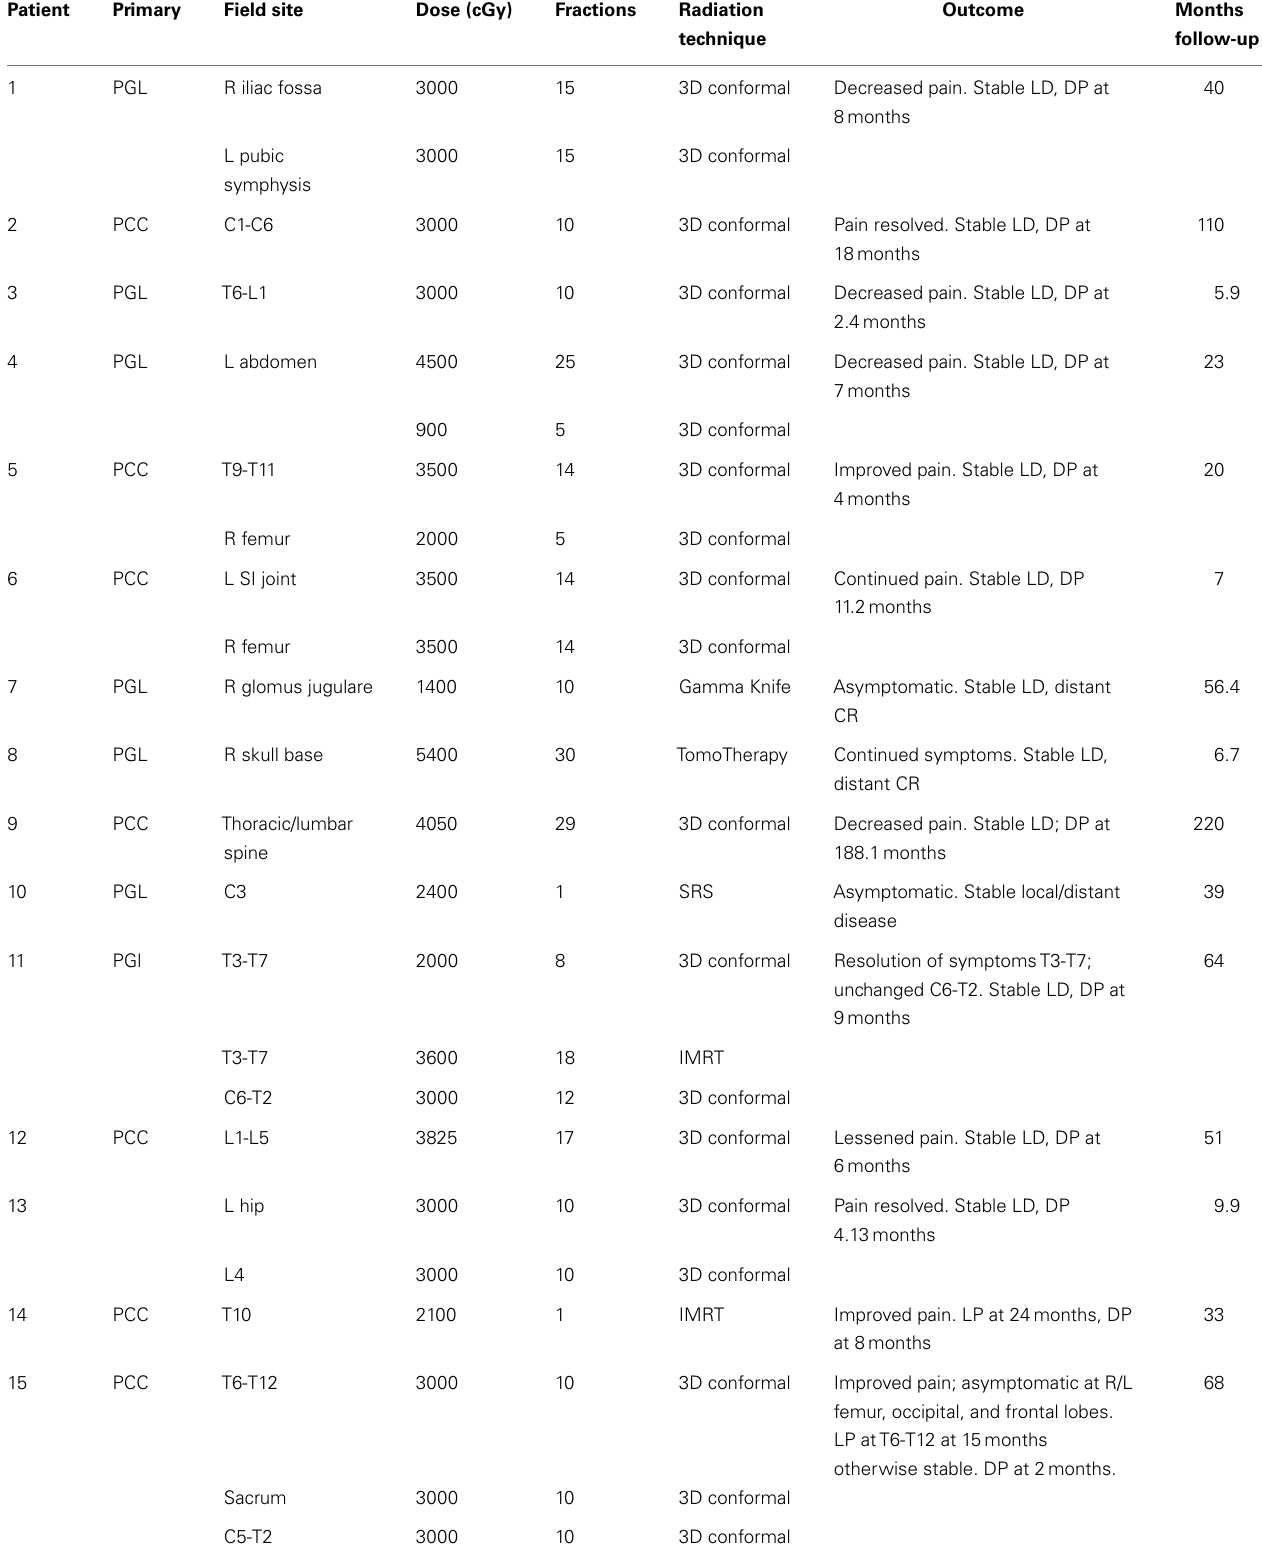
Table 3 | Results of EBRT therapy